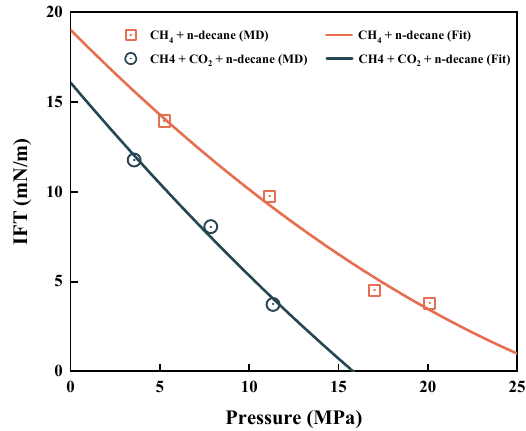
Figure 8. IFT of CH 4 /n-decane before and after CO 2 injection at 313.3 K.